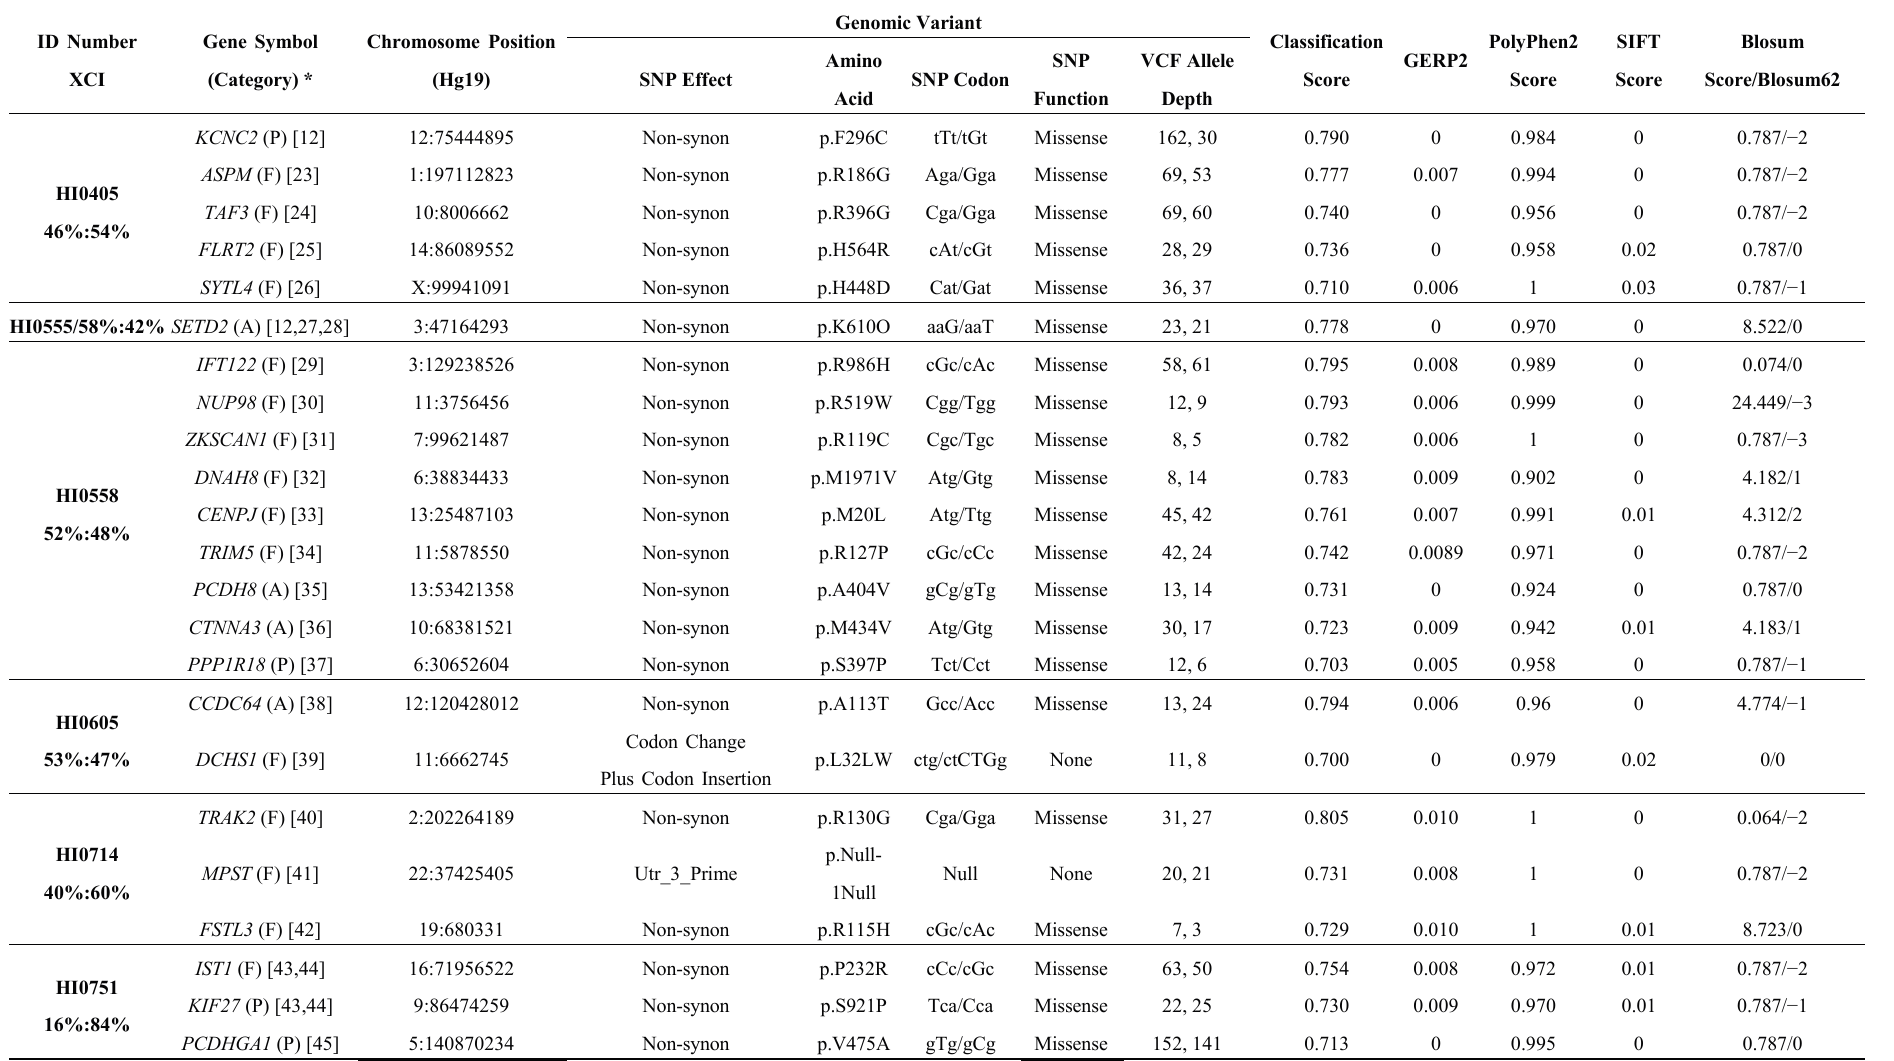
Table 1. Putative disease causing genes for autism identified using whole exome sequencing of females with autism spectrum disorder (ASD). ID